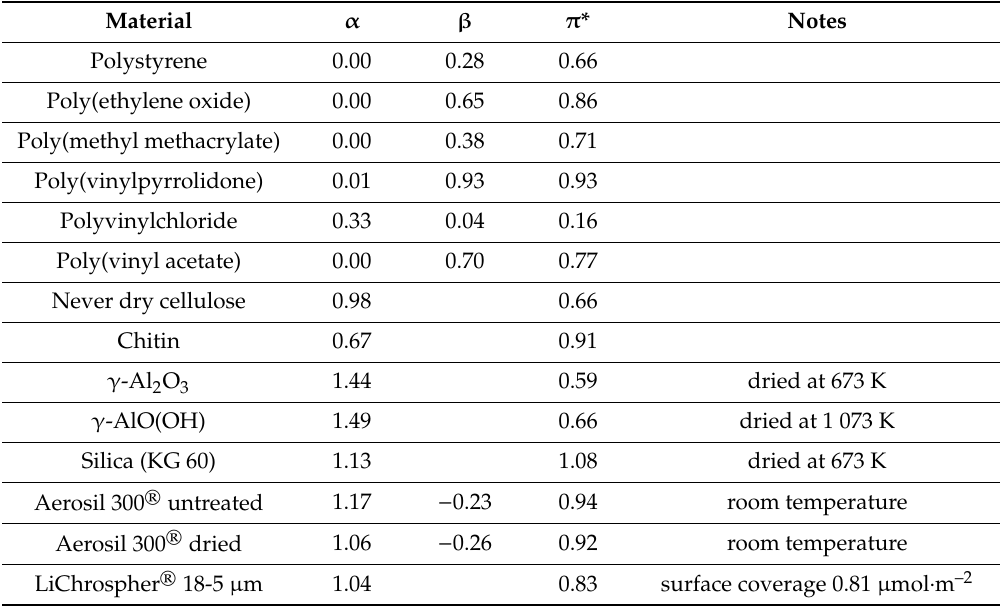
Table 5. Values of Kamlet-Taft π *, α , and β parameters for solid materials [52]. Material α β π * Notes Polystyrene